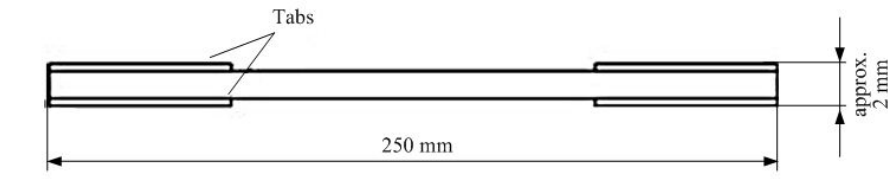
Figure 3: Side view of the tensile test specimens with tabs according to German standard DIN EN 2747